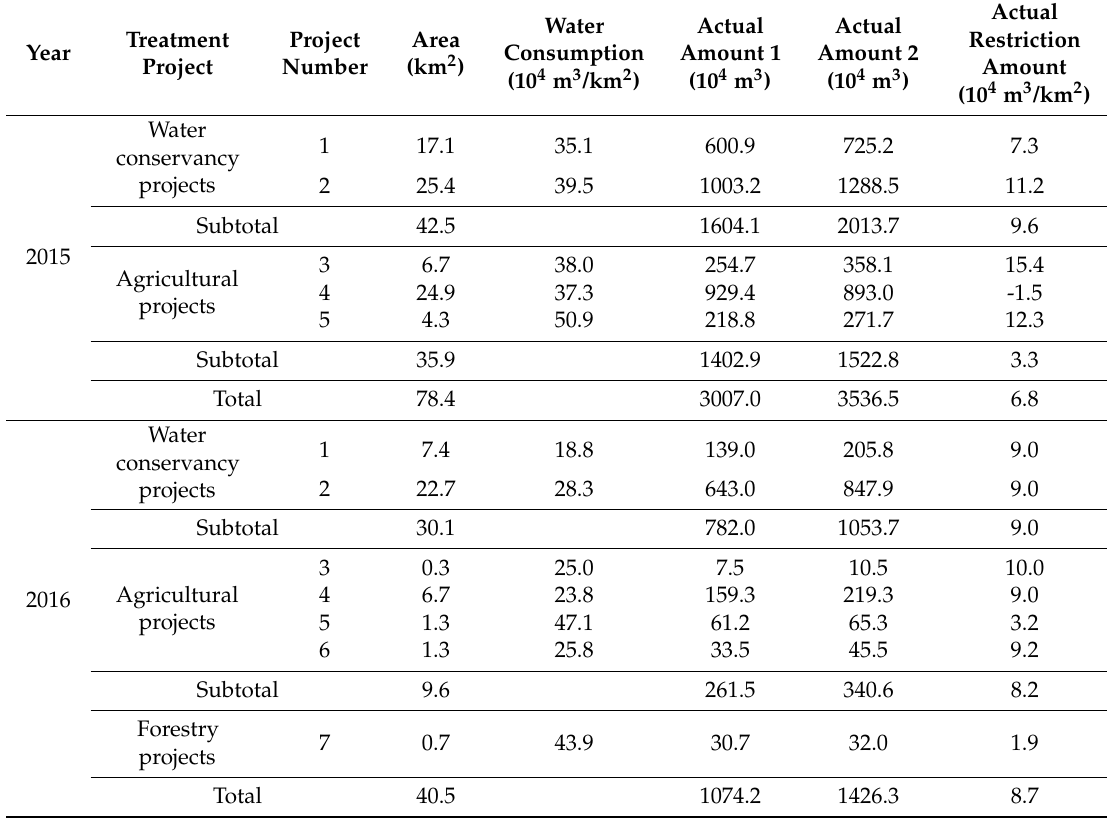
Table 4. Actual amount of agricultural groundwater exploitation in the project regions of Quzhou